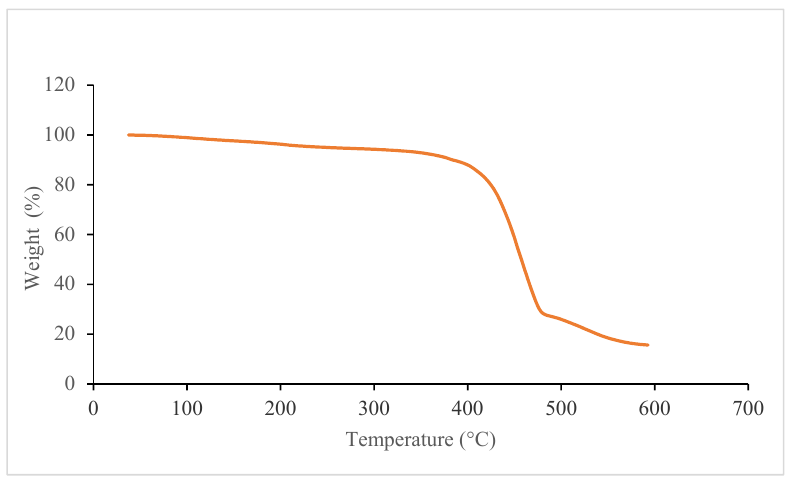
Figure 9. Thermogravimetric analysis (TGA) of polymer composites to obtain fibre for scanning electron microscopy (SEM) analysis.